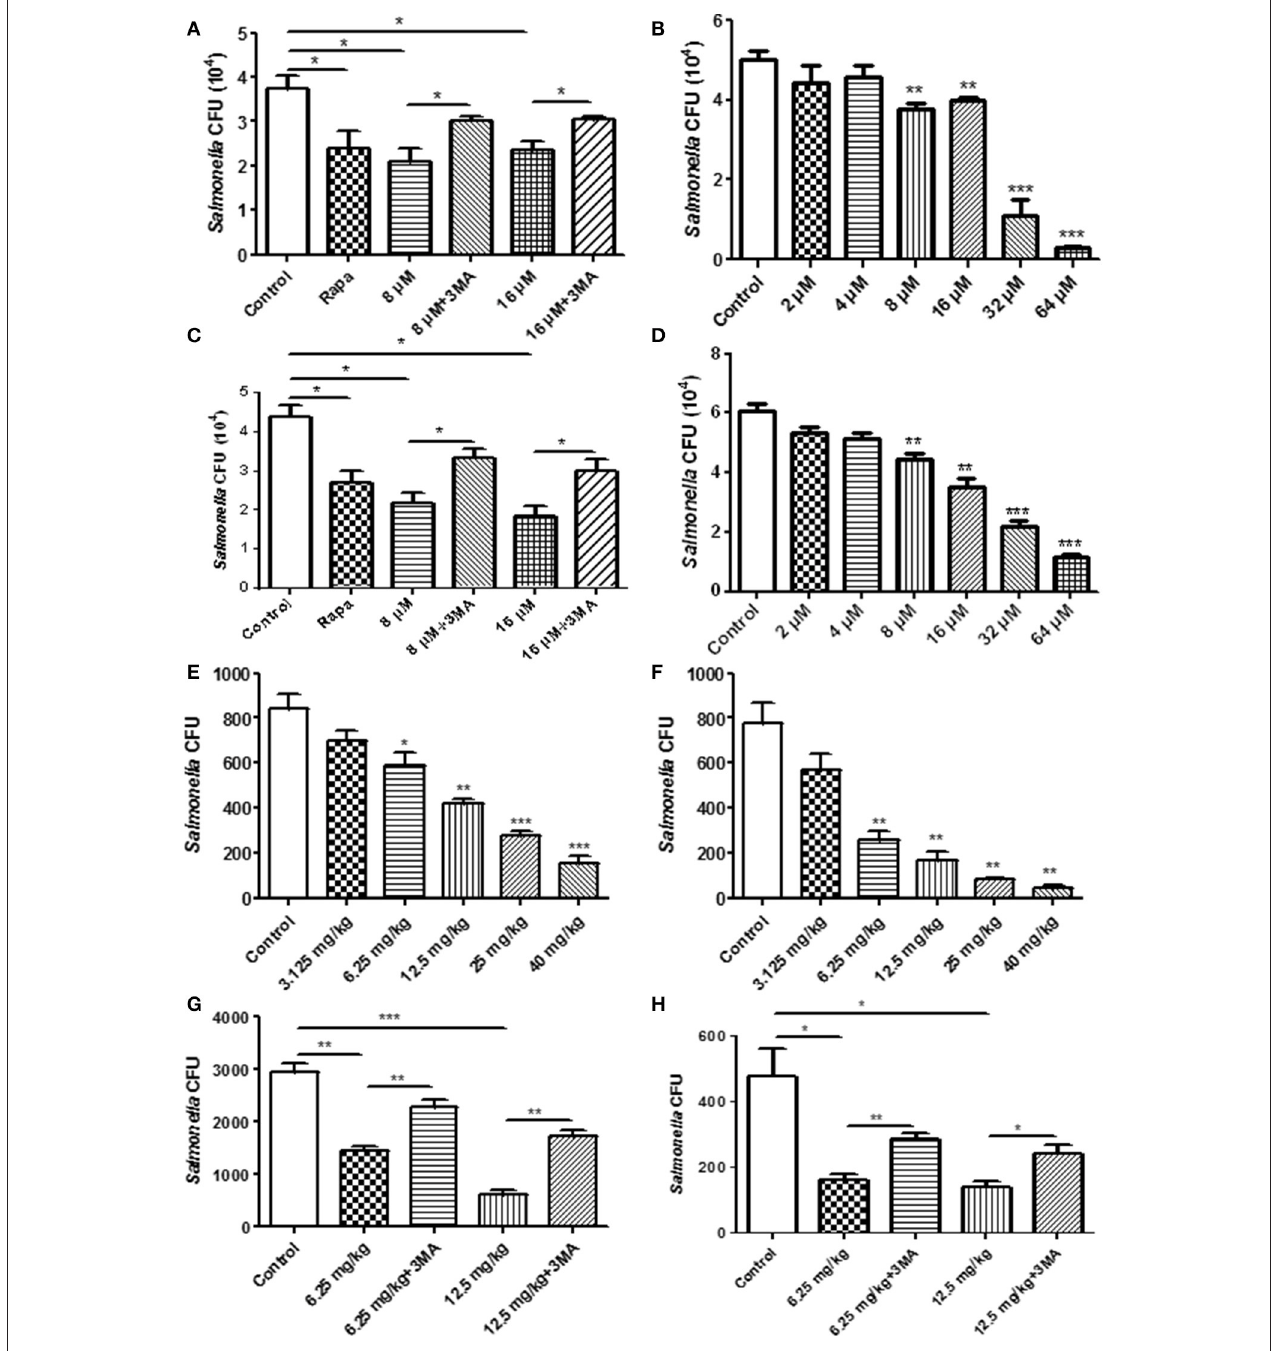
FIGURE 3 | The pathogen clearance ability is enhanced by TCS treatment in vitro and in vivo. RAW264.7 cells were incubated with Rapa (200nM, 12h), 3-MA (5mM, 180min), and TCS (8 µ M, 90min) (A) or TCS (0–64 µ M, 90min) (B) first and then infected with S. typhimurium at an MOI of 25:1. Colony counting was used to calculate the extracellular CFU. RAW264.7 cells were incubated with S. typhimurium at an MOI of 25:1 for 120min. The cells were then treated with Rapa (200nM, 12h), 3-MA (5mM, 180min), and TCS (8 µ M, 90min) (C) or TCS (0–64 µ M, 90min) (D) for 90min. Colony counting was used to calculate the intracellular CFU. Female BALB/c mice were infected with S. typhimurium for 24h, and the mice were treated with TCS once a day for 4 days. The livers (E) and spleens (F) were homogenized for colony counting. BALB/c mice were infected with S. typhimurium for 24h, and the mice were treated with or without 3-MA (24 mg/kg) first and were then injected with TCS once a day for 4 days. The livers and spleens were homogenized for colony counting (G,H) . Compared to the respective controls, * p < 0.05, ** p < 0.01, *** p < 0.001.